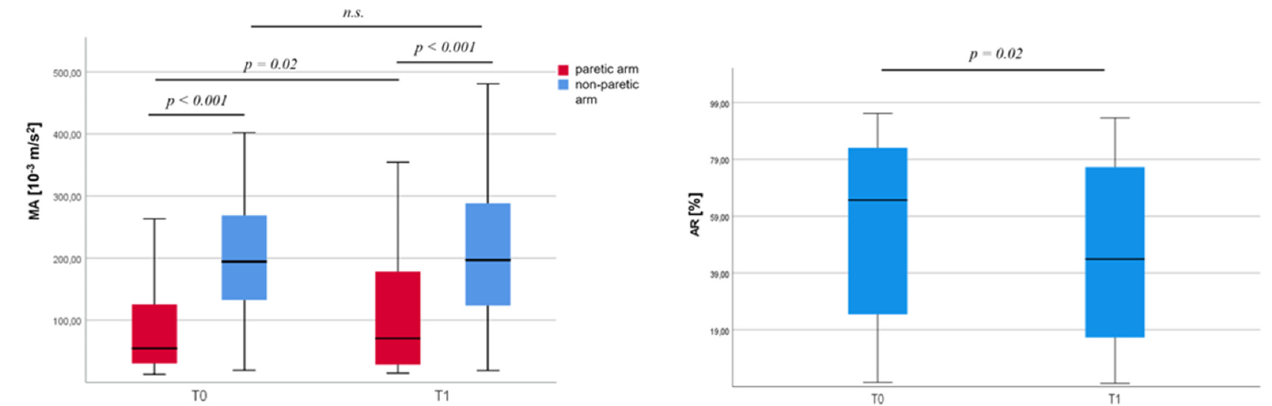
Figure 2. Changes of actigraphic parameters between T0 and T1. AR = Asymmetry Index, MA = Motor Activity index.